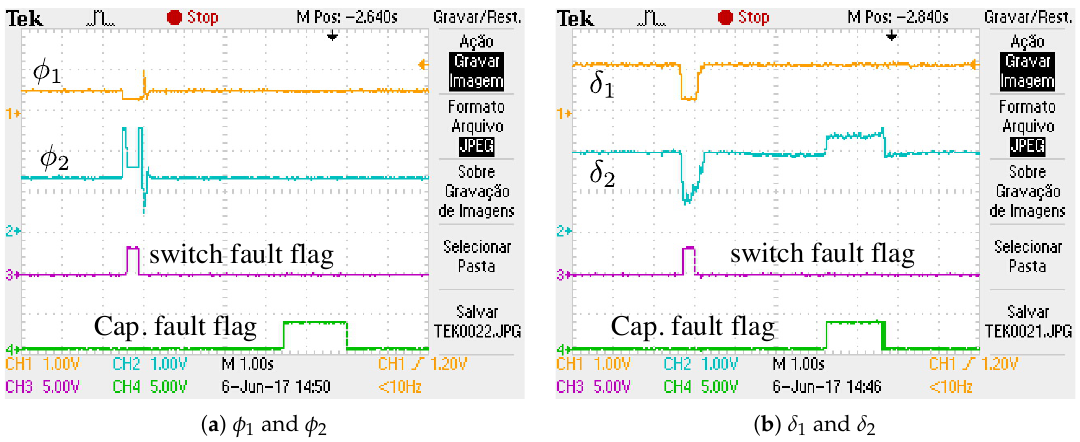
Figure 19. Experimental detection and isolation of faults in switch and